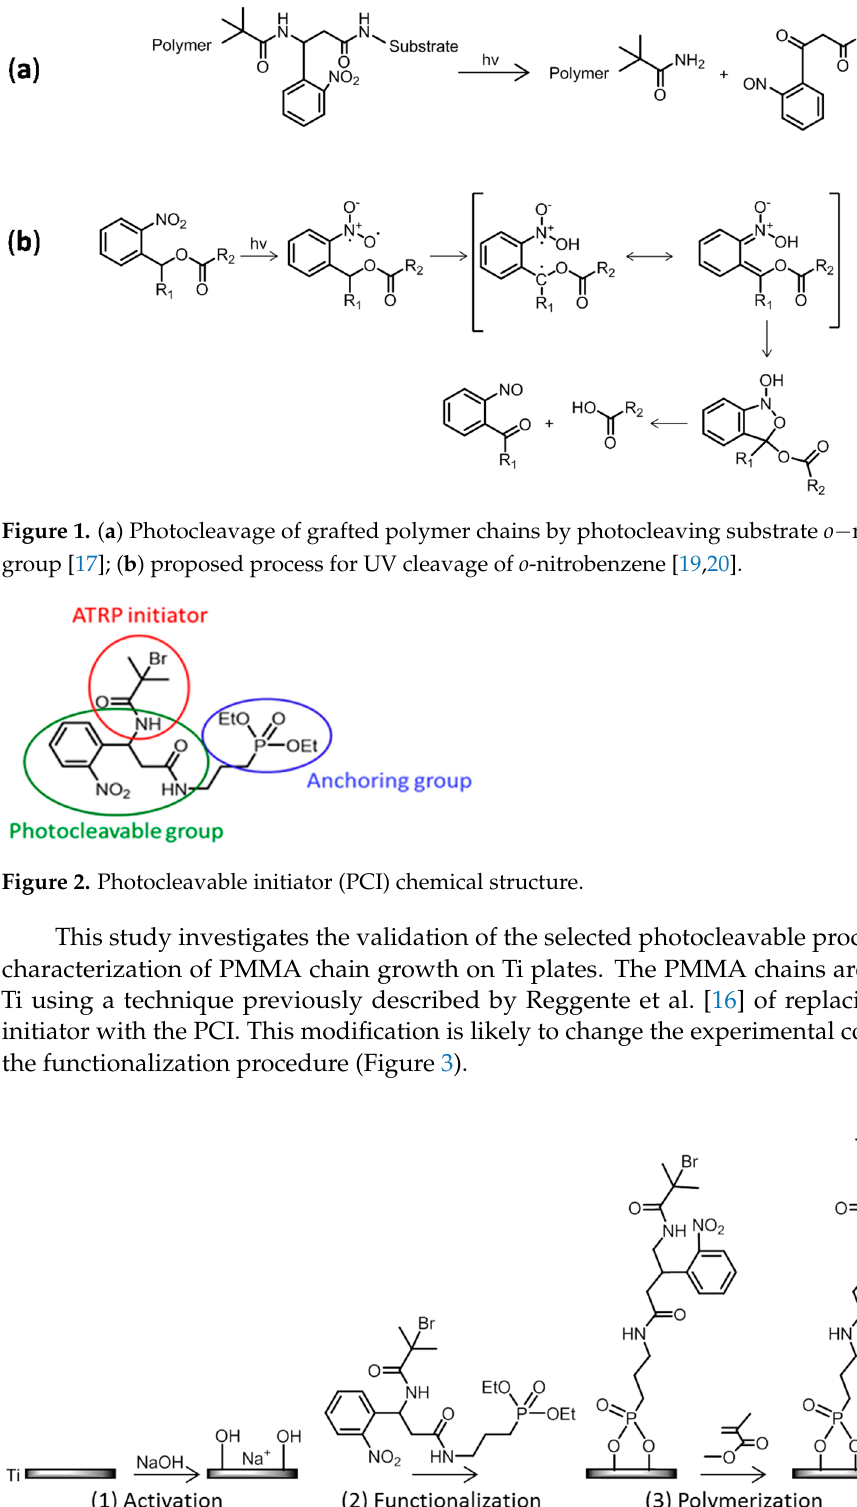
Figure 3. Three-step strategy used to design PMMA-coated Ti surfaces.